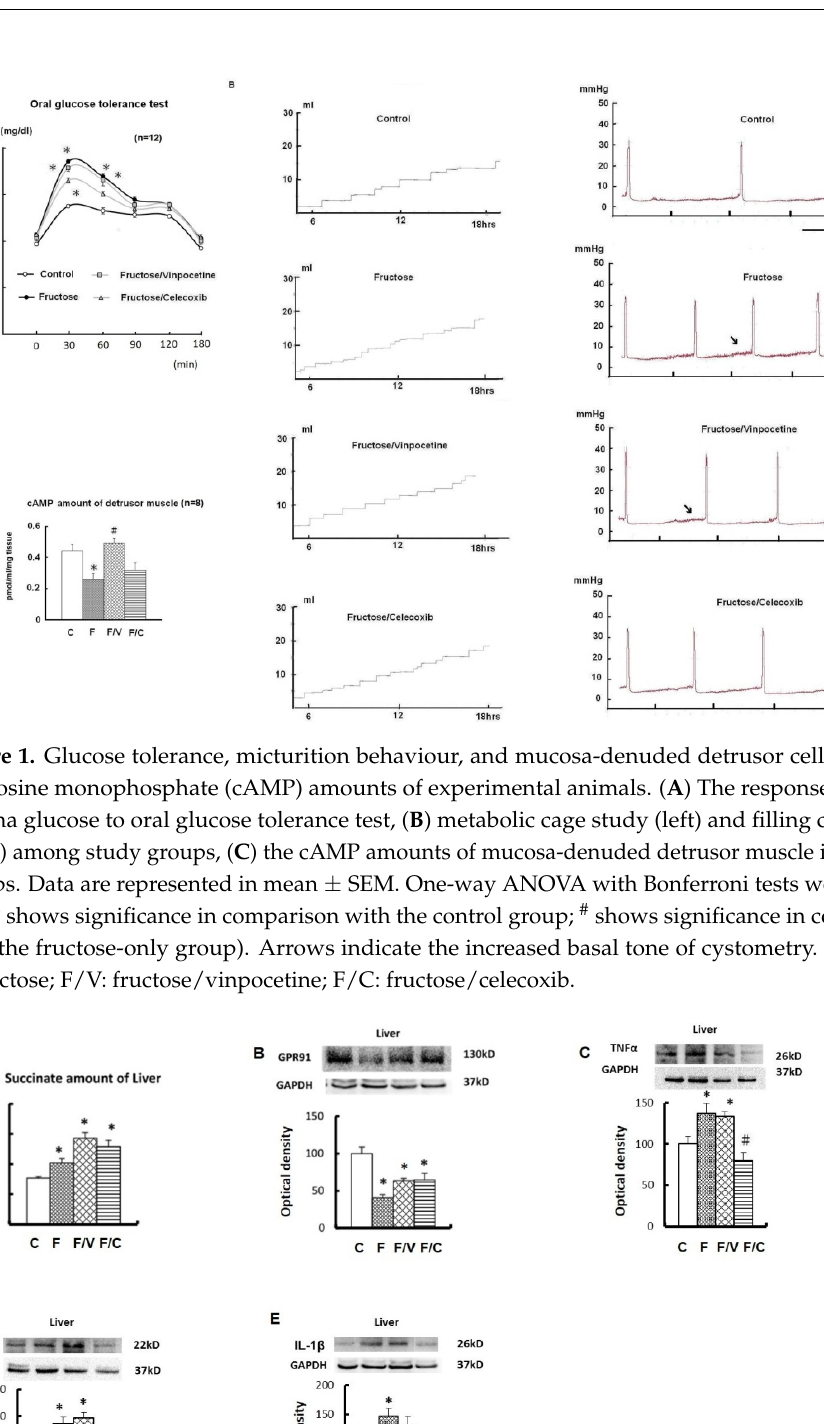
Figure 3. The effects of long-term fructose feeding on hepatic fibrosis, lipid steatosis, and fibrogen- esis markers. ( A ) Masson’s trichrome stain of liver tissues in different groups. Arrowhead: the zone- 3 perisinusoidal fibrosis. Reduced from 4×. ( B ) Masson’s trichrome stain of liver tissues in different groups. Arrowhead indicates fibrous portal expansion in the fructose-only group. Arrow: lipid ste- atosis in all fructose groups. Reduced from 40×. ( C – F ) Western blots of TGF- β 1, α -SMA, collagen I, and collagen III, respectively, of liver tissues among groups. Data are expressed as mean ± SEM. n = 8. * p < 0.05 versus controls and # with versus fructose group.